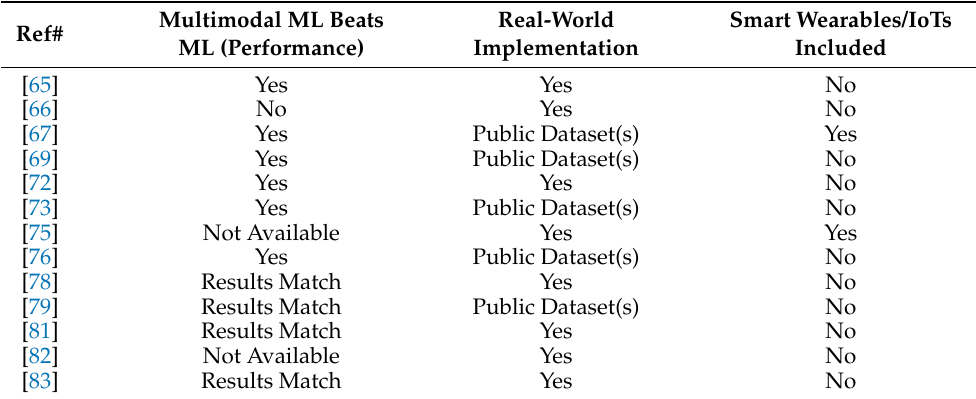
Table 5. Key findings in state-of-the-art of Multimodal ML in CVDs diagnosis. Ref#